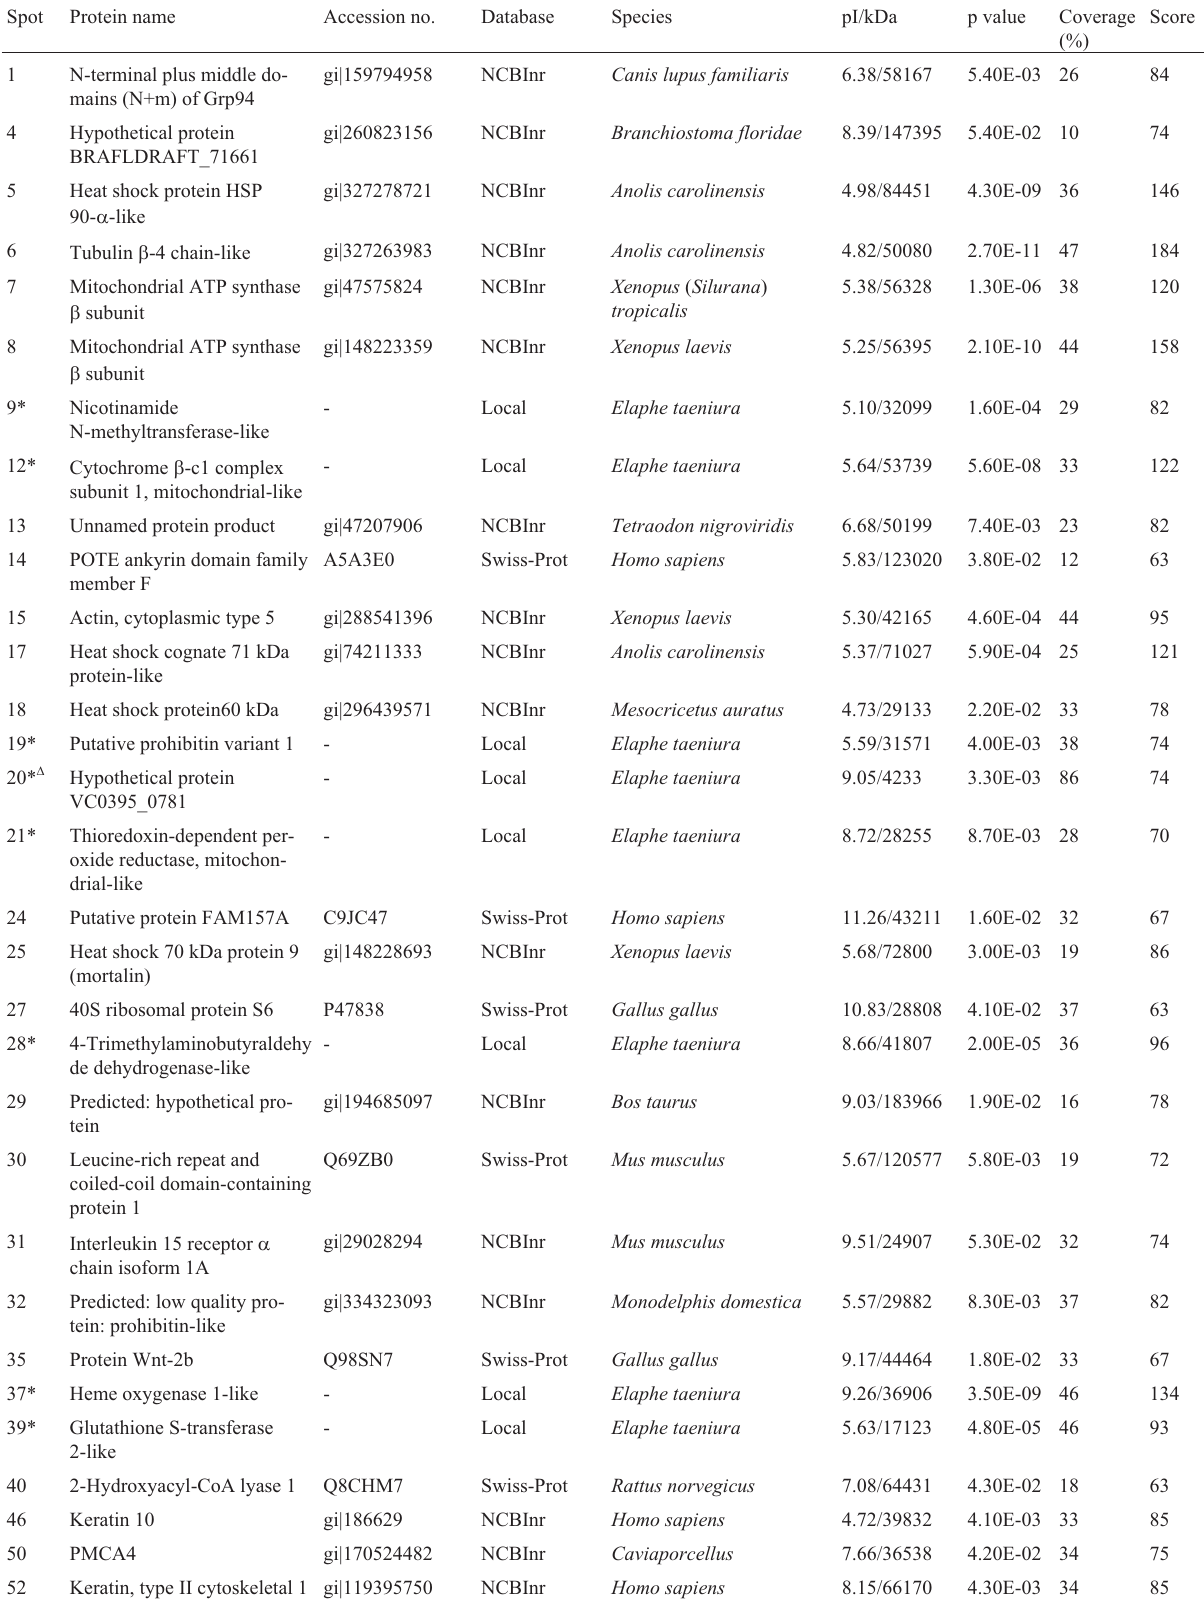
Table 1 - Proteins identified by MALDI-TOF mass spectrometry and